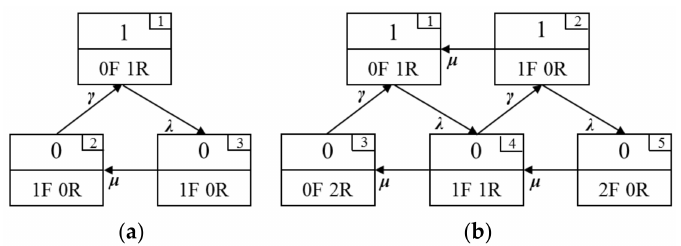
Figure 6. State space model of basic device for reliability analysis: ( a ) Basic device without spare; ( b ) Basic device with 1